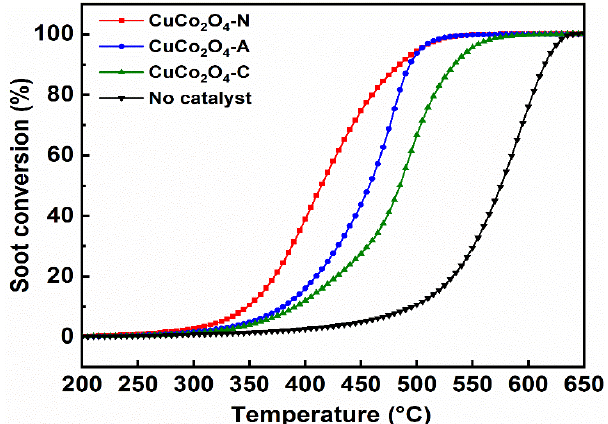
Figure 8. Soot conversion of the CuCo 2 O 4 - x ( x = N, A and C) catalysts under the loose contact mode with 1000 ppm NO.